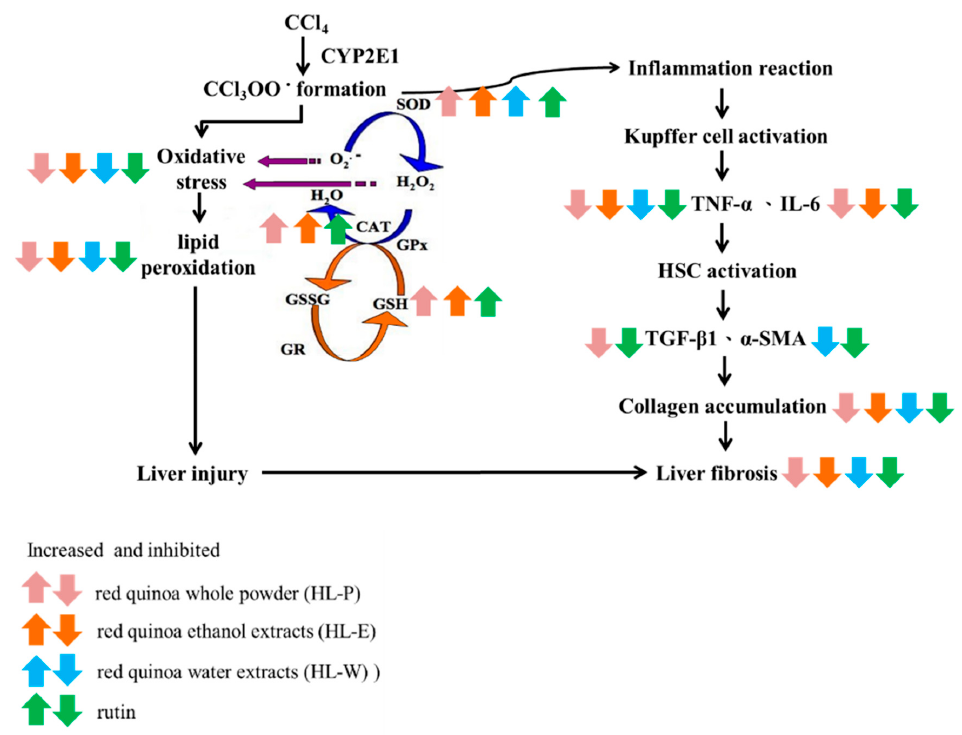
Figure 7. The regulation of red quinoa, red quinoa extracts and rutin in liver of CCl 4 -induced liver injury mice.